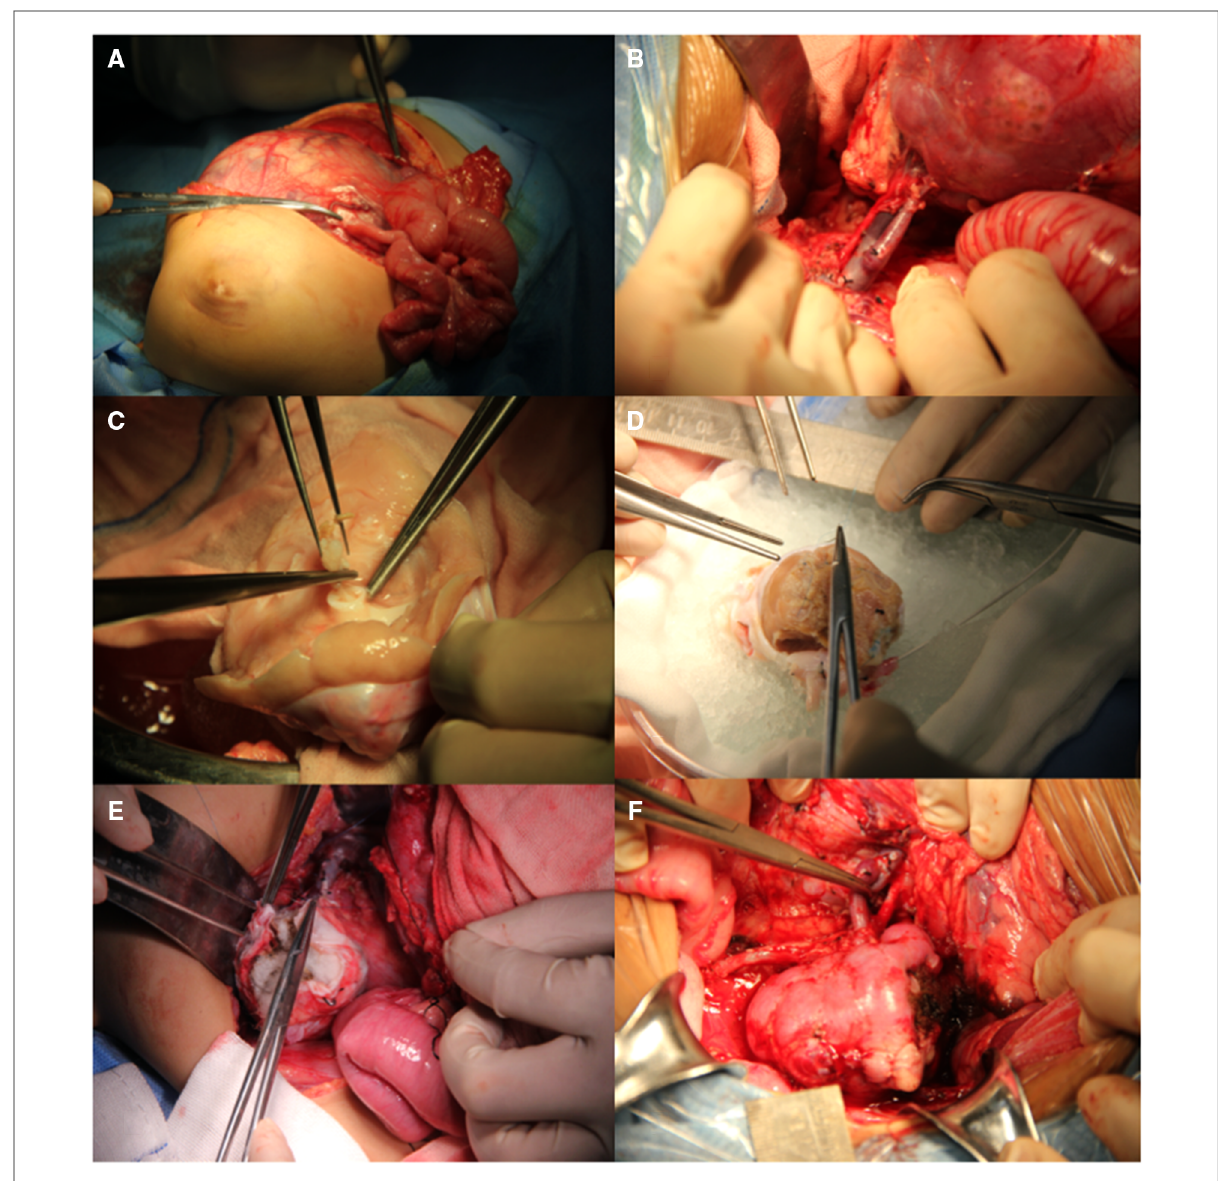
FIGURE 1 Surgical procedure of BS-AT. ( A ) Transverse upper abdominal incision. ( B ) Renal pedicle was well exposed. ( C ) Tumor removal in the renal pelvis. ( D ) Residual renal parenchyma and renal pelvis system were reconstructed with cooling perfusion. ( E ) Hemostatic sponge was used to cover the residual kidney. ( F ) Orthotopic kidney transplantation with vascular and ureteral